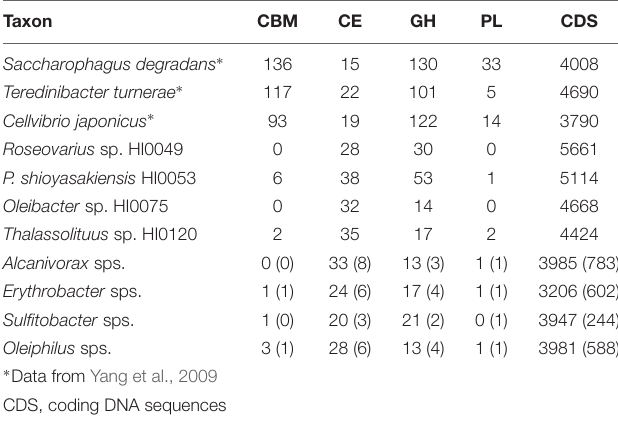
TABLE 2 | The number of predicted carbohydrate-active (CAZy) enzymes in representative bacterial